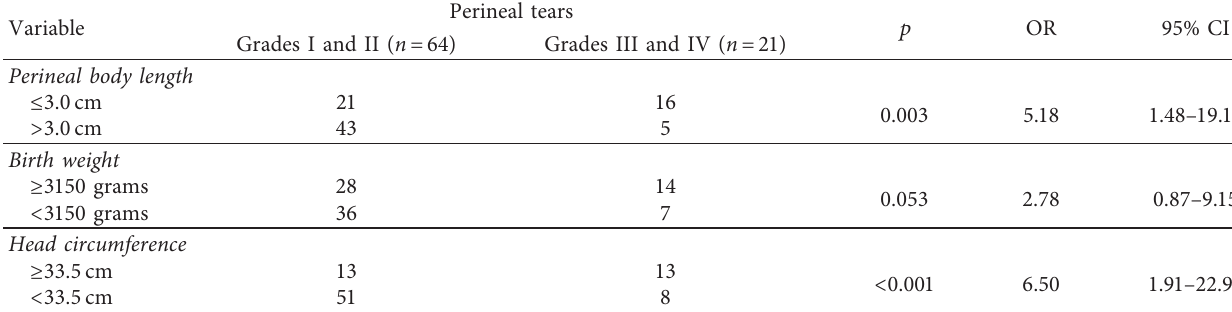
Table 5: Odds ratio and p value between risk factors and perineal tears.